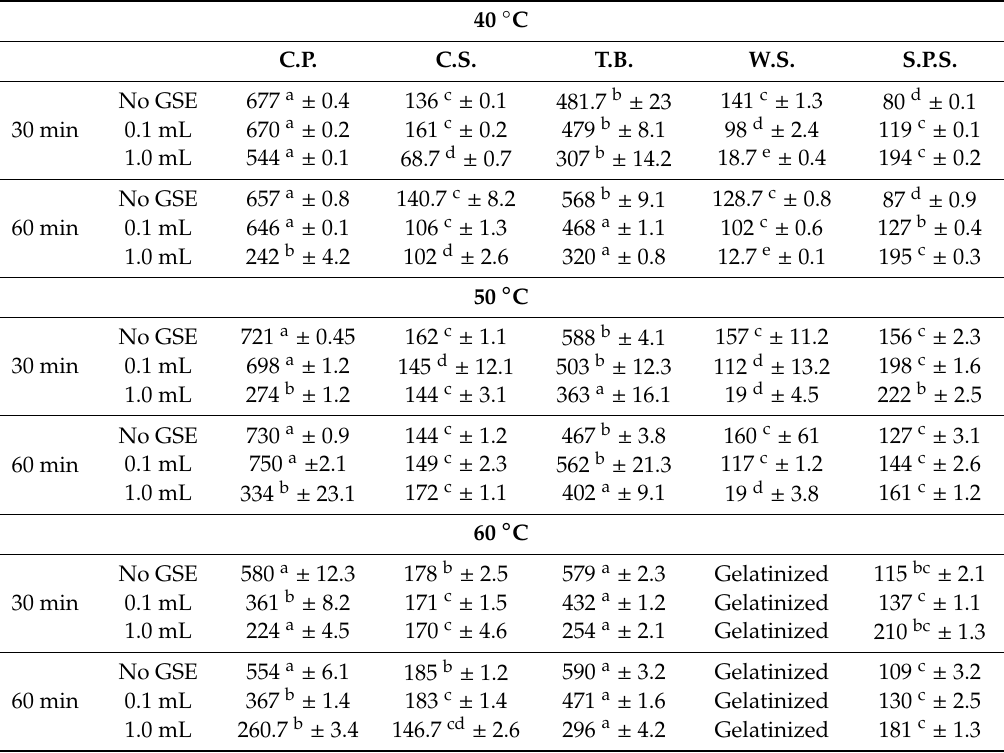
Table 4. The e ff ect of germinated sorghum extract (GSE) on starch gel hardness